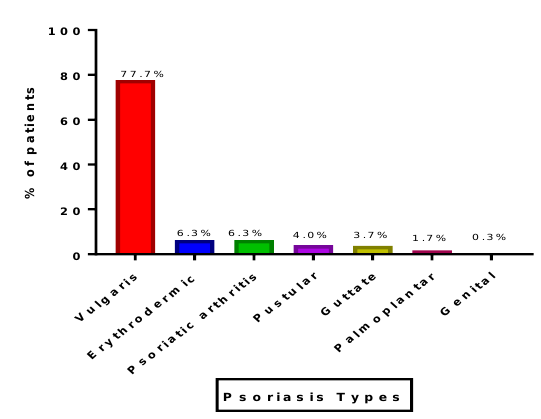
Figure 1. The types of psoriasis affected the participating patients The most commonly used medications to treat psoriasis were topical steroids (63%), systemic etanercept (biological therapy) (61.7%) and vaseline (41.3%) (Table 2). Table 2. The prescribed medications to treat